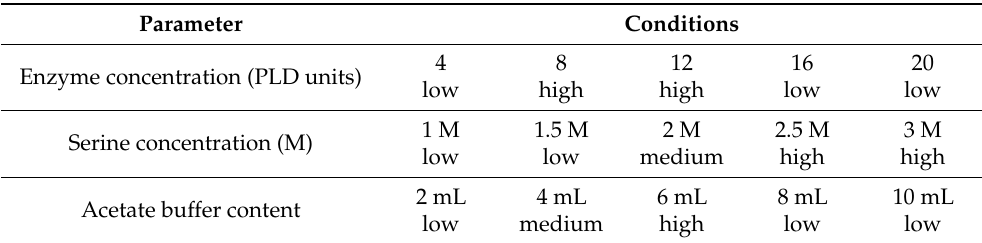
4 8 12 16 20 low high high low low 1 M 1.5 M 2 M 2.5 M low low medium high 6 medium